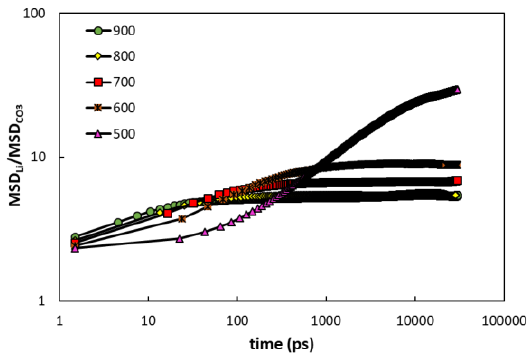
Figure 5. Ratio of cation and anion MSD(t) at different temperatures.